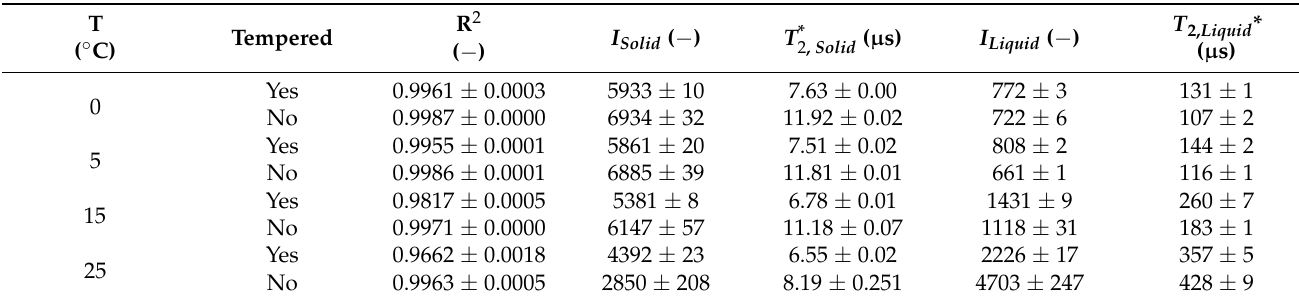
was fixed at 15.81 µ s, whereas A was fixed at 2, β ( (cid:48) )